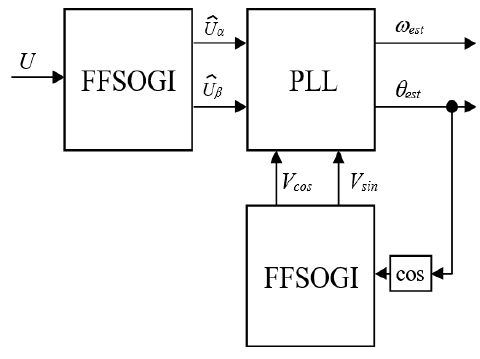
Figure 3. The FFPLL2 structure.